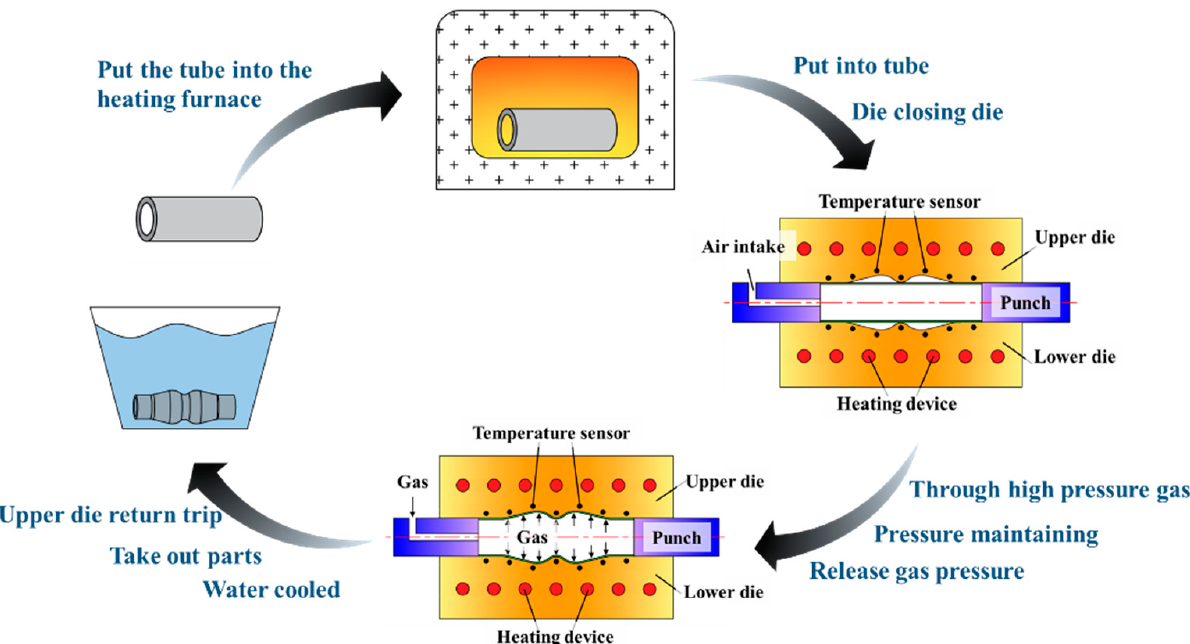
Figure 4. Schematic diagram of hot gas bulging.